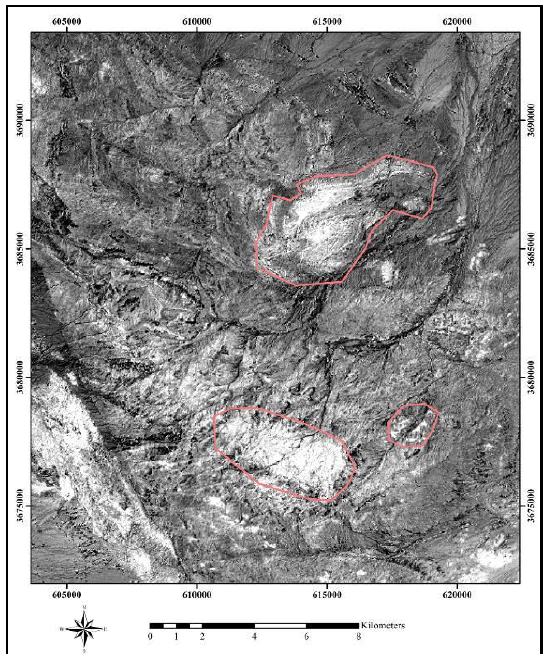
Figure 4. PC2 image for the Ardestan scene; ellipsoidal polygons separate bright pixels as probable locations of the pyrite mineral.